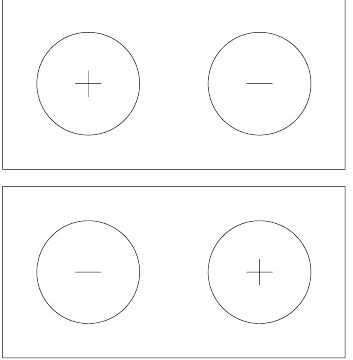
Figure 1. If all the energy ends up in the lowest wavenumber mode of the rectangular domain, it must occupy one of the two states